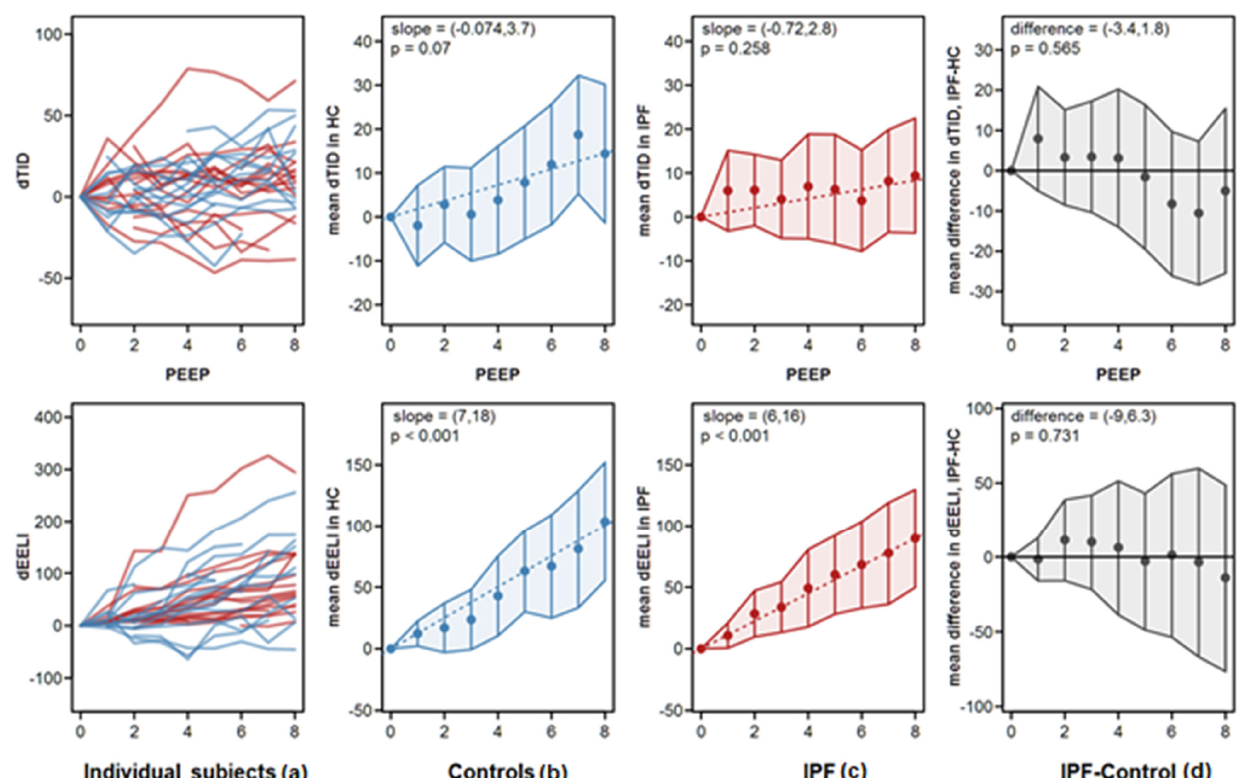
Figure 1. Global change in difference of tidal impedance distribution over time (dTID) and difference of end-expiratory lung impedance over time (dEELI) during PEEP titration. Panels show, from left to right: ( a ) patient’s individual tra-jectories, ( b ) mean values by PEEP in controls, ( c ) mean values by PEEP in IPF patients, and ( d ) mean differences between IPF patients and controls. Blue lines indicate data from controls; red lines indicate data from IPF patients. Points represent mean values, error bars represent pointwise 95% confidence intervals. The dotted lines are the model fits for the change over PEEP. The 95% confidence intervals of the slopes of these lines are indicated in the panels. The difference in the right panels is the 95% confidence interval of the difference between the slopes for IPF patients and controls. Abbreviations: TID—tidal impedance distribution; dTID—difference of TID over time; dEELI—difference of end-expiratory lung im-pedance over time; PEEP—positive end-expiratory pressure. The statistical analysis showed that dEELI significantly increased over the PEEP increment ( p <